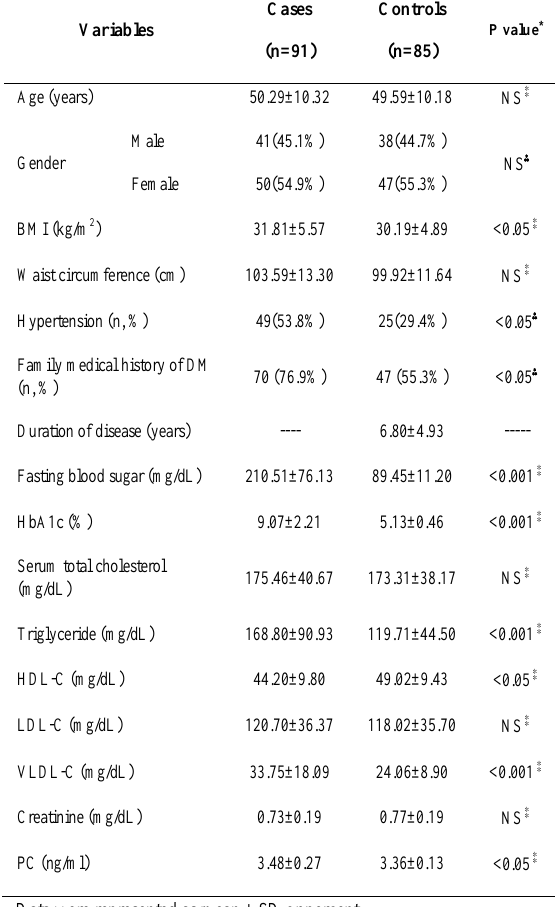
Table 1: Demographic, clinical and biochemical data of the participants.